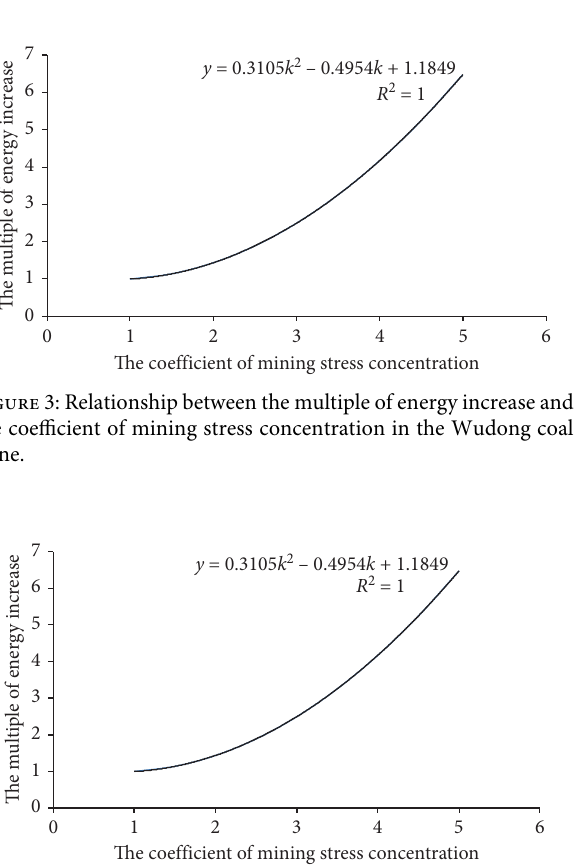
Figure 4: Relationship between the multiple of energy increase and the coefficient of mining stress concentration in the Laohutai coal mine.